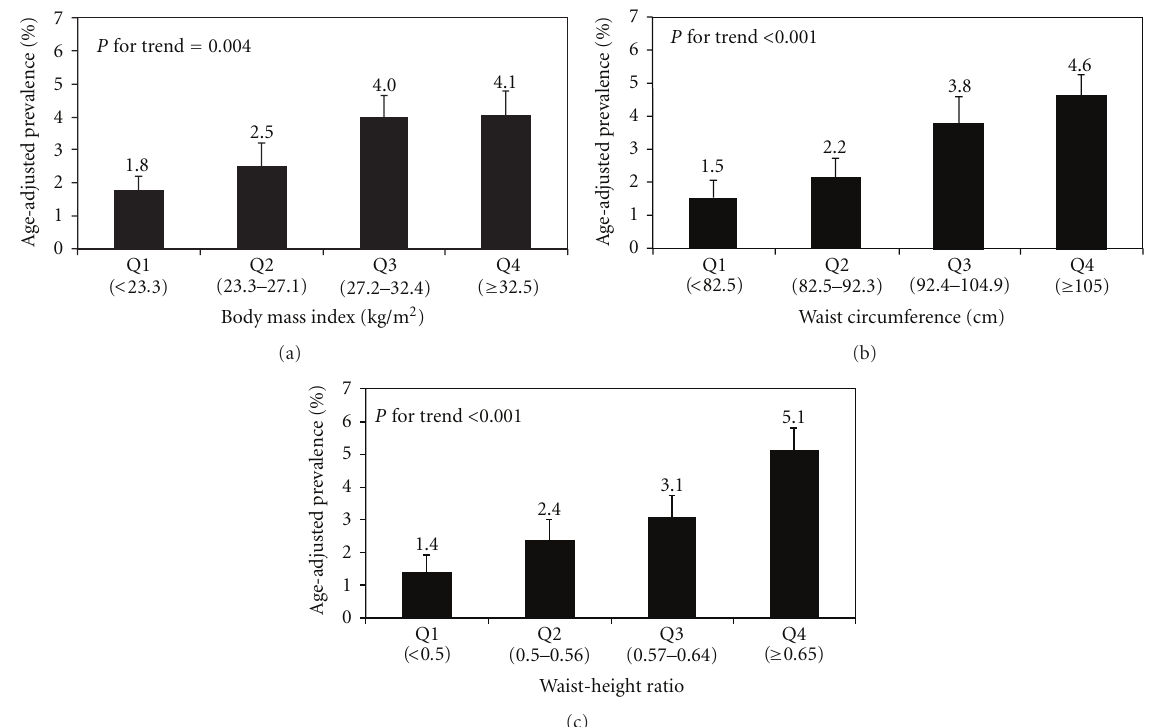
Figure 1: Age-adjusted prevalence (with standard error) of having suicidal ideation among US adult women by quartiles of body mass index, waist circumference, and waist-height ratio, NHANES